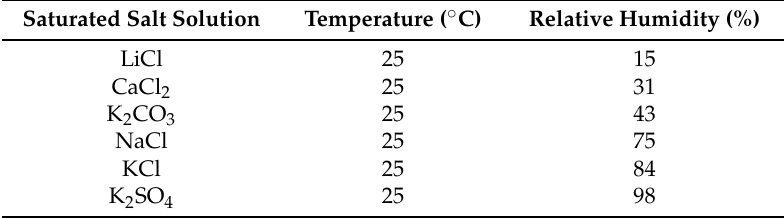
Table 1. Relative humidity (RH) values of normally used saturated salt solutions.